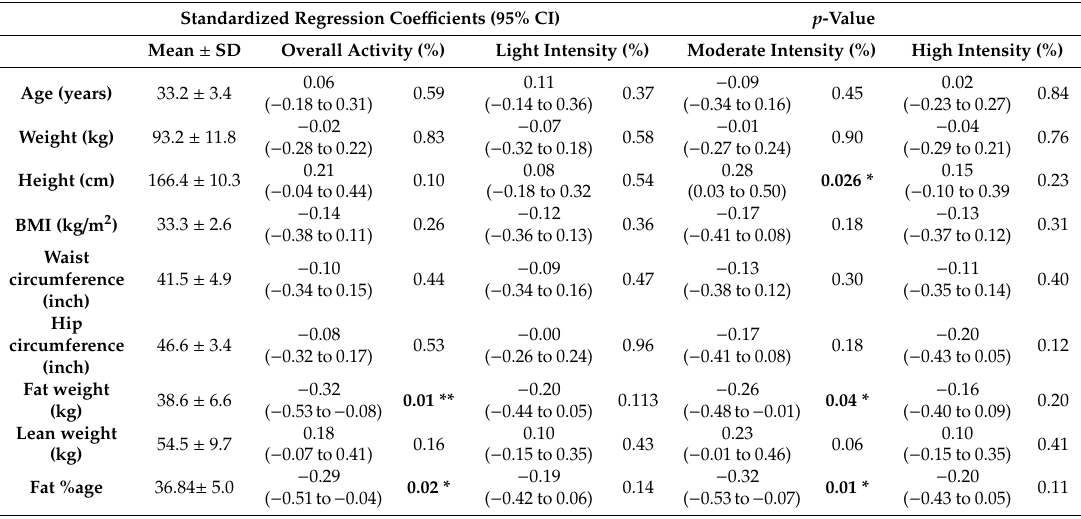
Table 1. Regression analysis of the percentage of time spent at di ff erent physical activity (PA) intensity levels and anthropometric / body composition characteristics